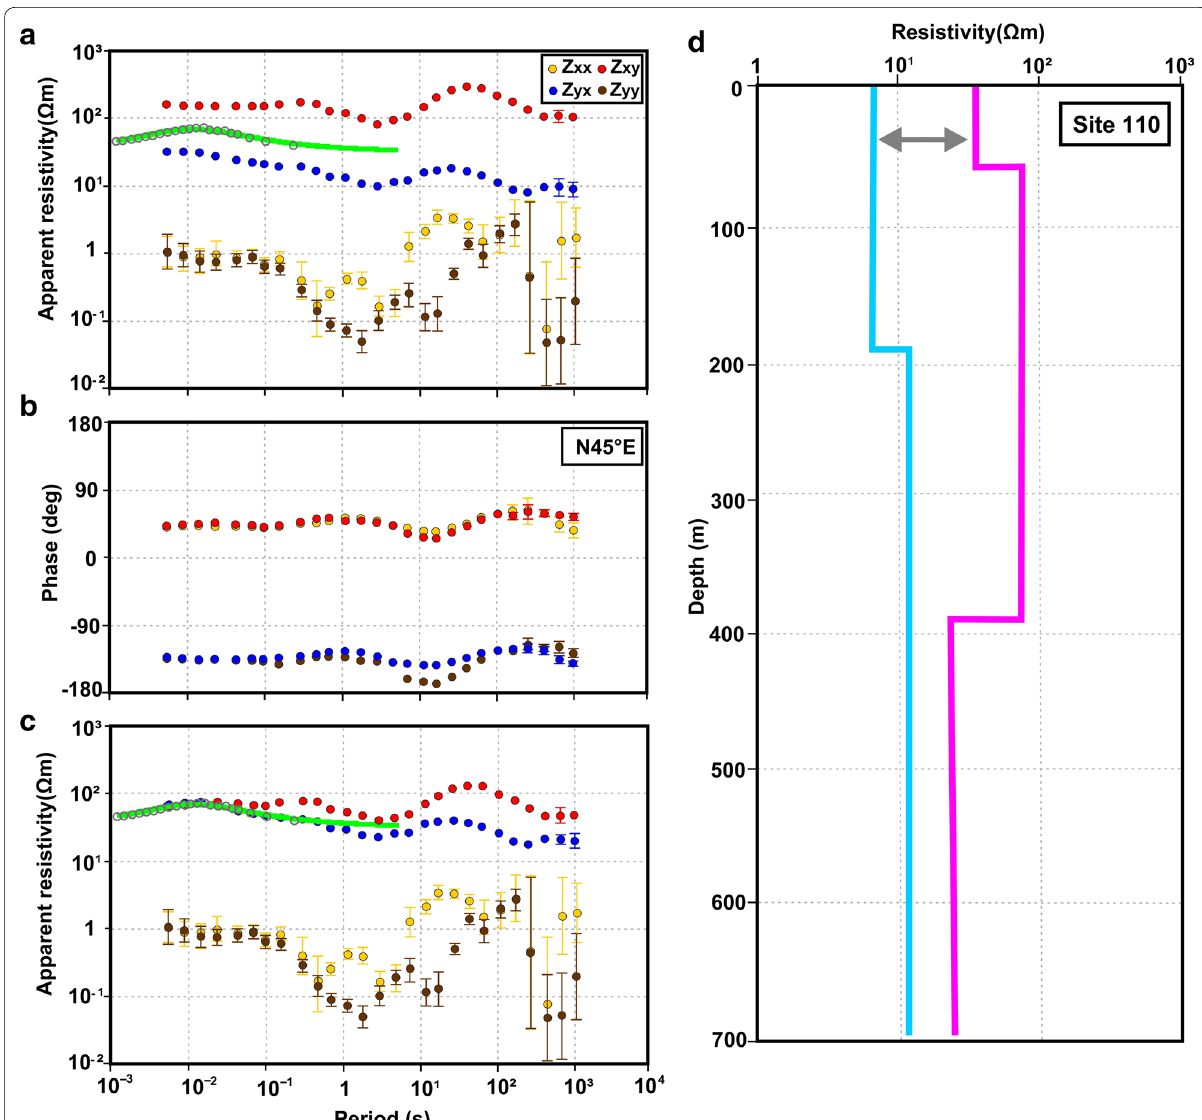
Fig. 2 MT static shift correction using the TEM data. a Comparison of the MT sounding curve with TEM sounding curve at site 110. b Phase of the 45° rotated MT sounding curves, showing that the curves are 1D at short periods. c Static shift-corrected MT sounding curves using 1D inversion of the central loop TEM data acquired at colocated site. d Comparison of the inverted 1D layered models corresponding to the TEM sounding data (pink) and shifted MT data (blue). Gray circles and green solid line are observed and calculated TEM data, respectively. The location of the site is shown in Fig.